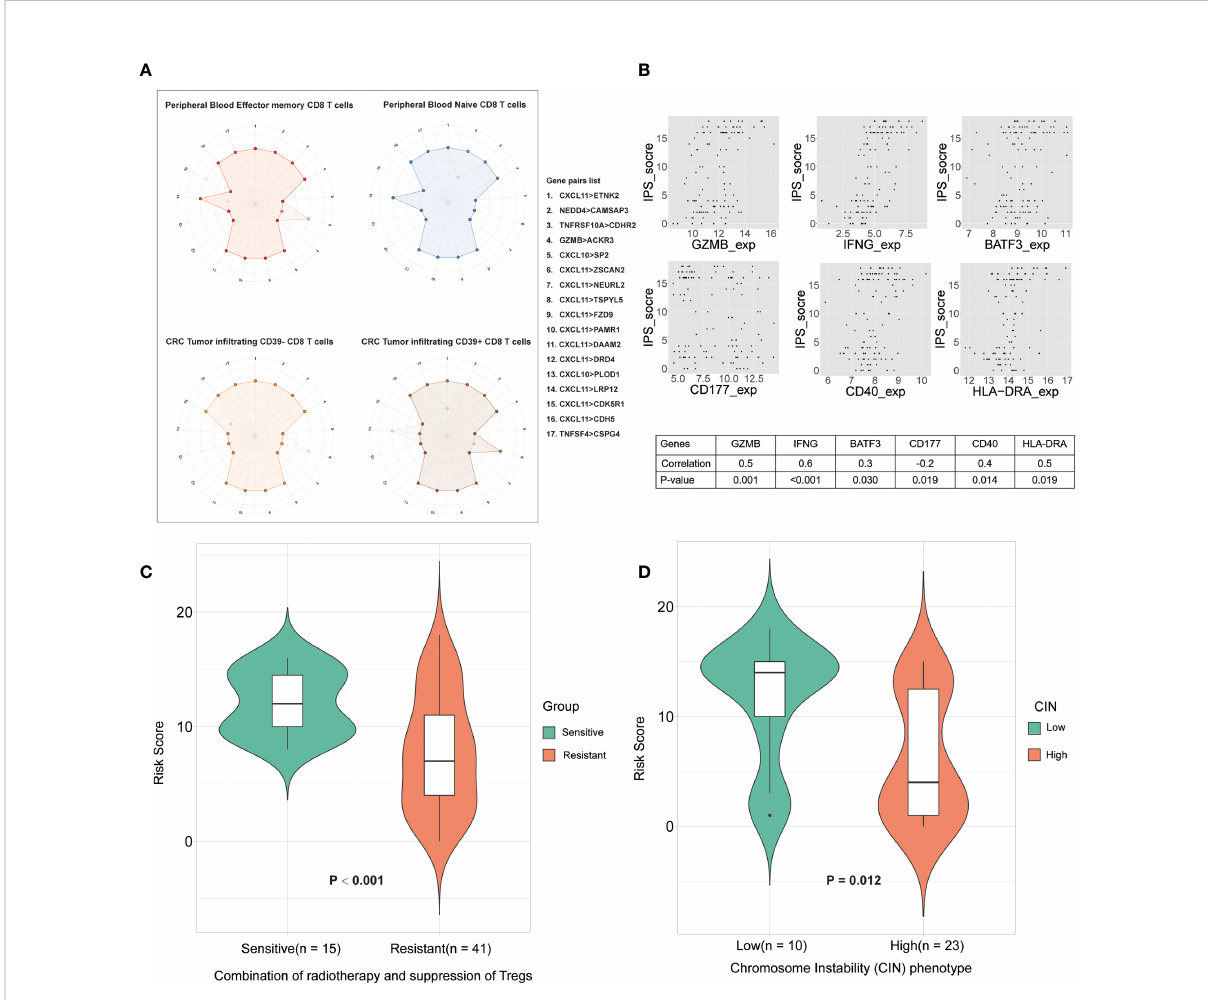
FIGURE 5 The relationship between IPS and the immune microenvironment. (A) Differences in CD8 T cell subtype scoring in IPS. Numbers 1 to17 (one missing) represent different gene pairs. Points in the outer circle are points with a score of 1, and points in the inner circle are points with a score of 0. Finally, overlay the plots for all samples of the same type. (B) Correlation between IPS-based immune scores and type I antitumor T cell expression values. The abscissa is the gene expression value, and the ordinate is the score. Finally, the correlation between them was calculated. (C) Immune scores between sensitive group and resistant group to radiotherapy. (D) Correlation between IPS-based immune score and chromosome instability